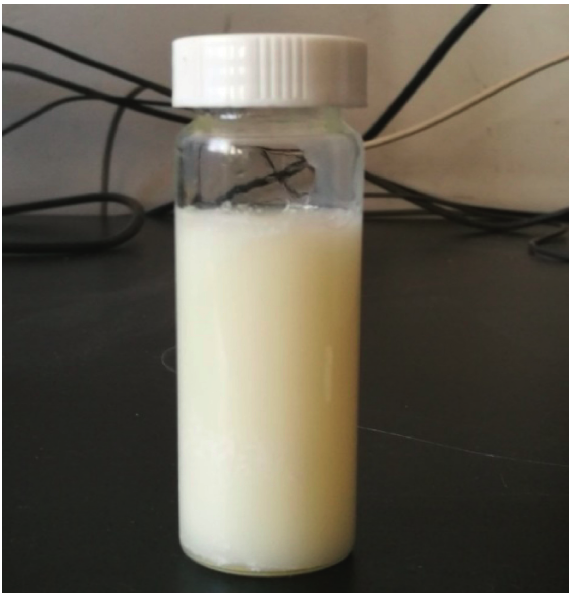
Figure 1: Image of the polymer microsphere as an oil displacement profile control